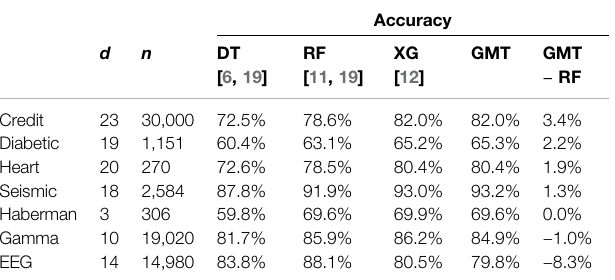
TABLE 1 | Accuracy of DT, RF, XG, and GMT for several data sets. We apply a shuf fl ed 10-fold cross validation to each test. Results are sorted by relative performance, starting from hightest accuracy difference between GMT and